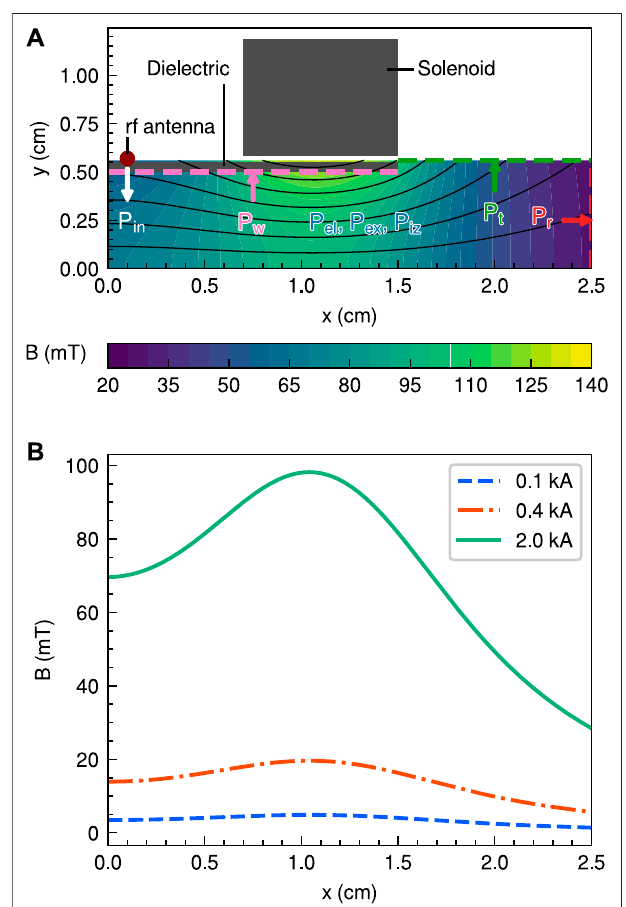
FIGURE 1 | (A) A schematic of the calculation area and a magnetic fi eld strength produced by the solenoid current of 2.0 kA. Solid black lines show the magnetic fi eld lines. Energy fl uxes and collisional energy losses in the magneticnozzleradiofrequency(RF)plasmathrusterarealsoplotted. P in is the input power from the RF antenna (a white arrow). P w , P r , and P t are energy losses per unit time from colliding with the lateral dielectric wall (a pink arrow), from colliding with the right boundary at x (cid:1) 2.5 cm (a red arrow), and from colliding with the top boundary at y (cid:1) 0.56 cm (a green arrow), respectively. These energy losses per unit time are calculated independently from particle motions for ions and electrons and the x -, y -, and z -directions. P el , P ex ,and P iz aretheelastic,excitation,and ionizationenergylossesperunit time, respectively (a blue font). Because the left and bottom boundaries are assumed to be symmetrical, particles are re fl ected at the boundaries, and the particle energies are not lost. (B) Magnetic fi eld strengths on the x -axis for the three solenoid currents of 0.1 (a dashed blue line), 0.4 (a dotted-dashed orange line), and 2.0 kA (a solid green